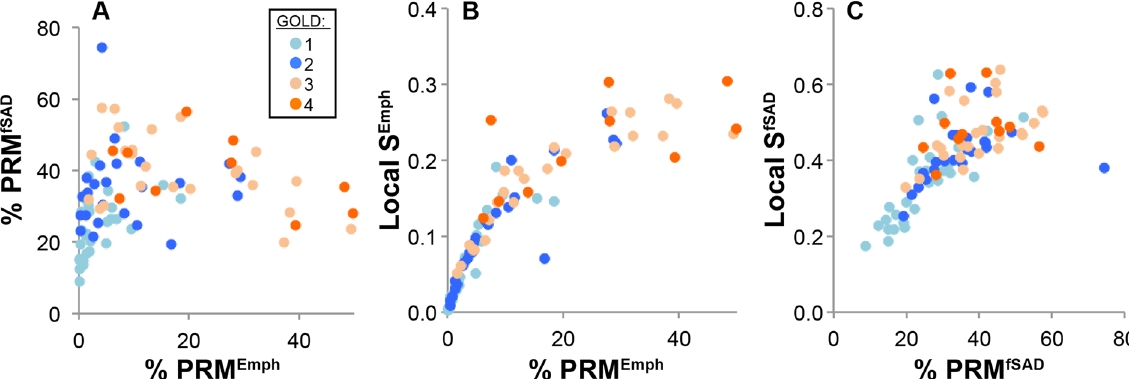
Figure 3. Observable trends between PRM and topological PRM features. Scatter plots are presented for ( A ) %PRM Emph vs. %PRM fSAD , ( B ) %PRM Emph vs. Local S Emph and ( C ) %PRM fSAD vs. Local S fSAD . Markers are color- coded for GOLD 1 through 4 (see legend). Comparison between %PRM Emph and %PRM fSAD showed trends with increasing disease severity that has been observed in previously published work 21, 22 . Local S i values and respective %PRM i values reveals a strong correlation at low volume fractions showing greater spread with increasing volume